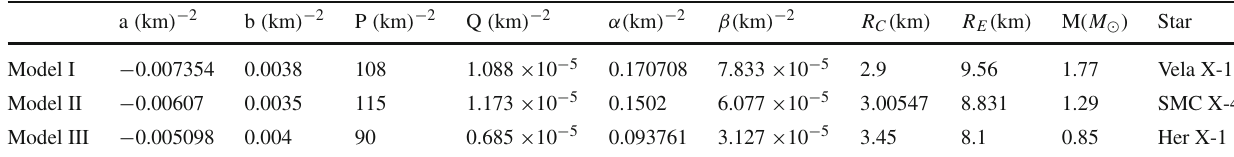
Table 1 Values of constants that generate masses, core and envelope radii ( R C , R E ) for the three well-known compact stars